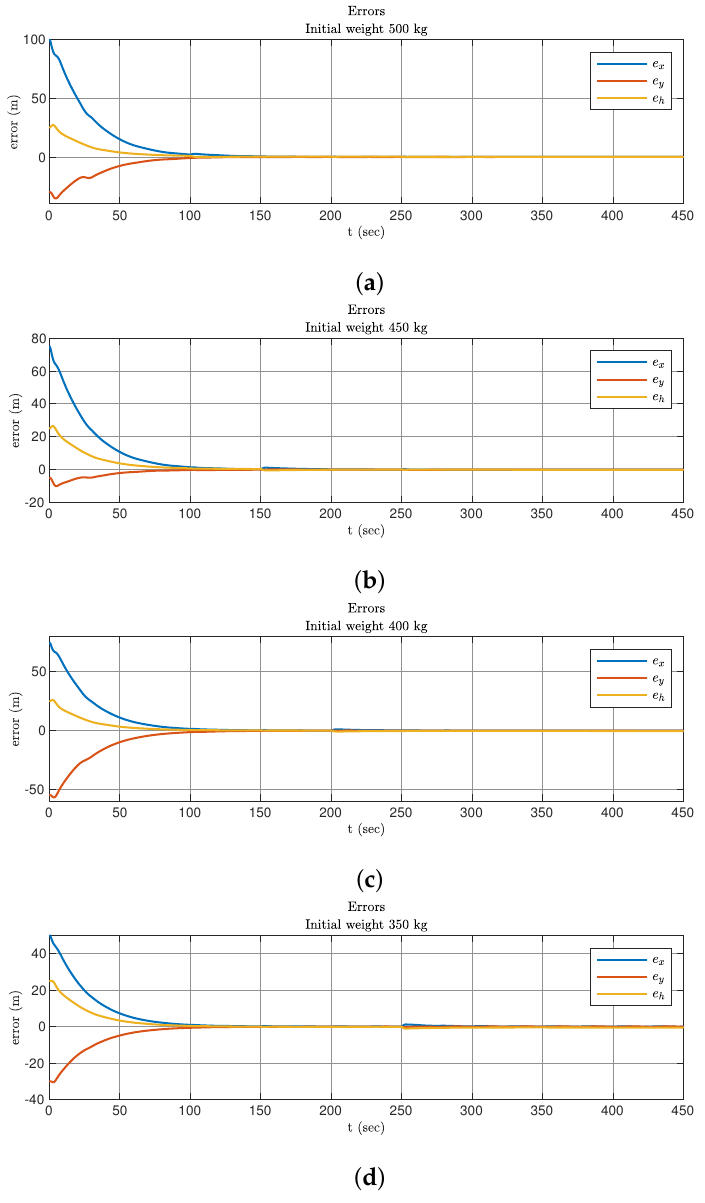
Figure 6. Coordinate errors for control the case of a group of UAVs of variable mass with initial mass values: 500 kg ( a ), 450 kg ( b ), 400 kg ( c ), 350 kg ( d